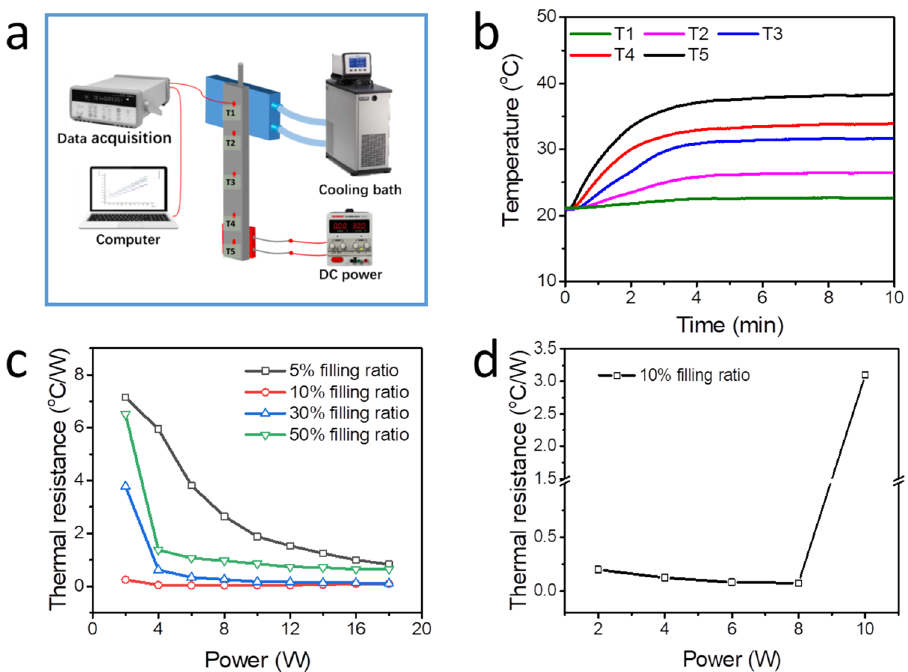
Figure 3. Experimental setup, and heat transfer performance, of the 3D-printed flat heat pipe: ( a ) schematics of the experimental setup; ( b ) temperature evolution of the 3D-printed flat heat pipe at a power of 2 W (at different positions along the heat pipe; T1–T5); ( c ) thermal resistance evolution of heat pipes loaded with different filling ratios (5%, 10%, 30% and 50%) of working fluid (in the vertical operation mode); ( d ) thermal resistance evolution of a heat pipe in the horizontal operation mode (for a 10% filling